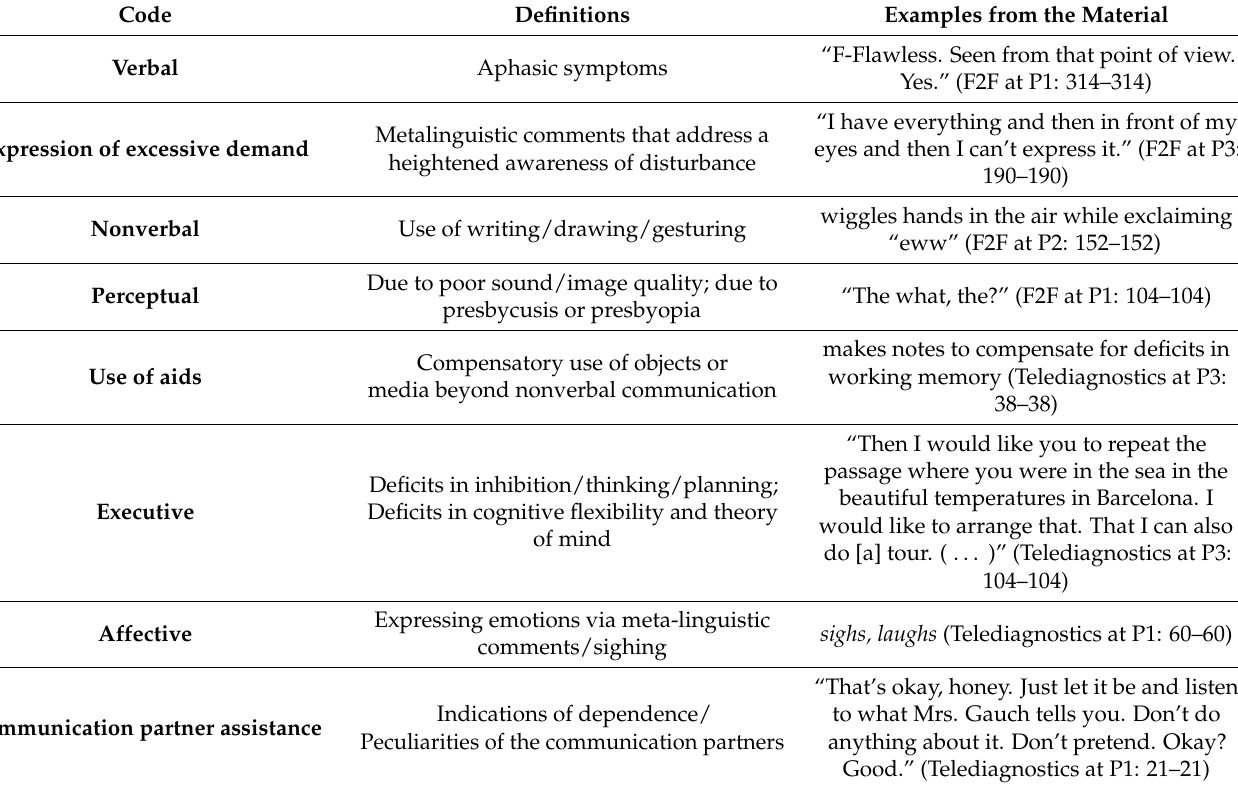
Table 2. Category system including codes, definitions, and